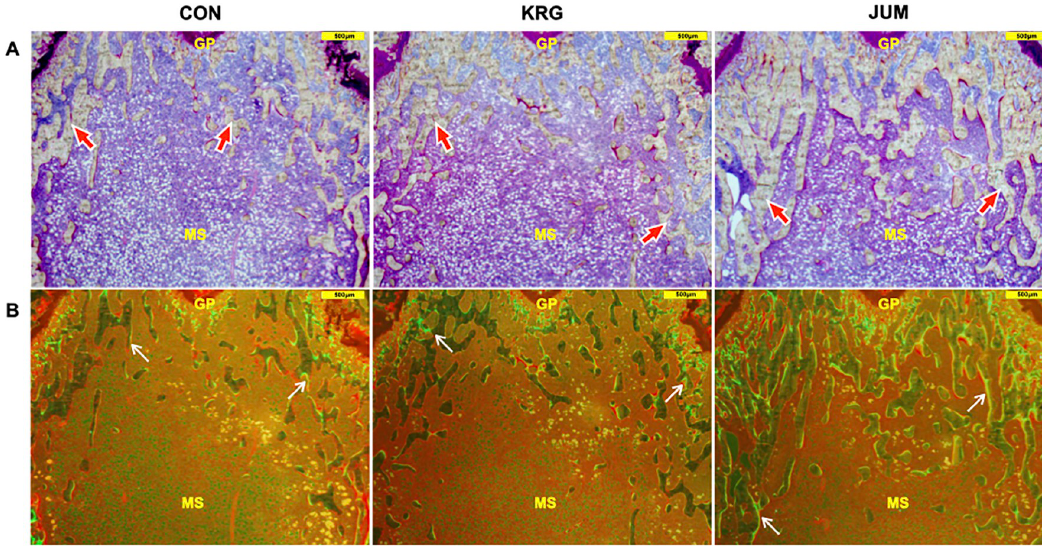
Fig 5. Histological images of the distal femoral metaphyseal region from each group. A) Representative sections of distal femurs under natural light. Red arrows show bone trabeculae. B) Representative sections of distal femurs under fluorescent light. The labeling surface with calcein is indicated by white arrows. Sections were stained by Villanueva staining. GP, growth plate; MS, marrow space; Scale bars (yellow) = 500 μ m. KRG, group administered 200 mg/kg body weight of Korean red ginseng daily; JUM, group that jumped 10 times/day from a height of 40 cm; CON, control group without exercise or KRG